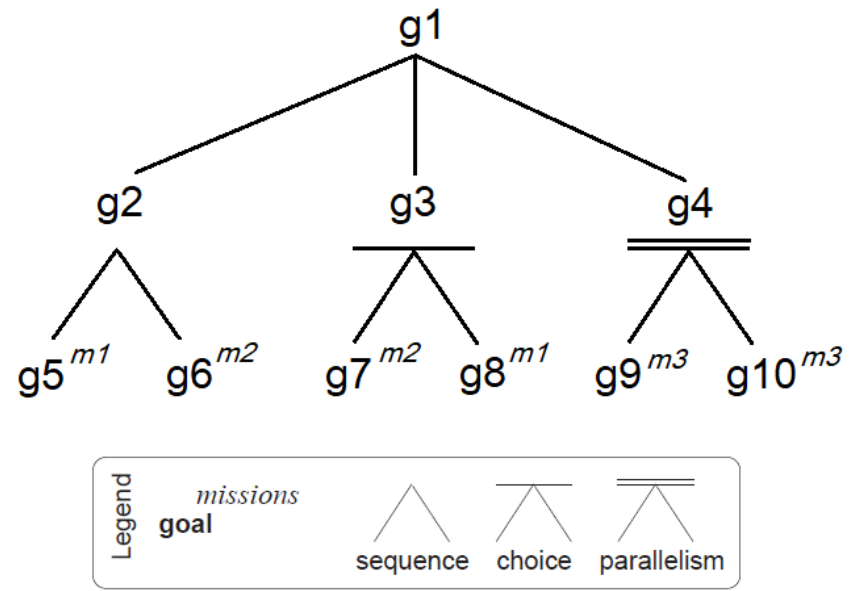
Figure 3. M oise + functional specification, based on [34].